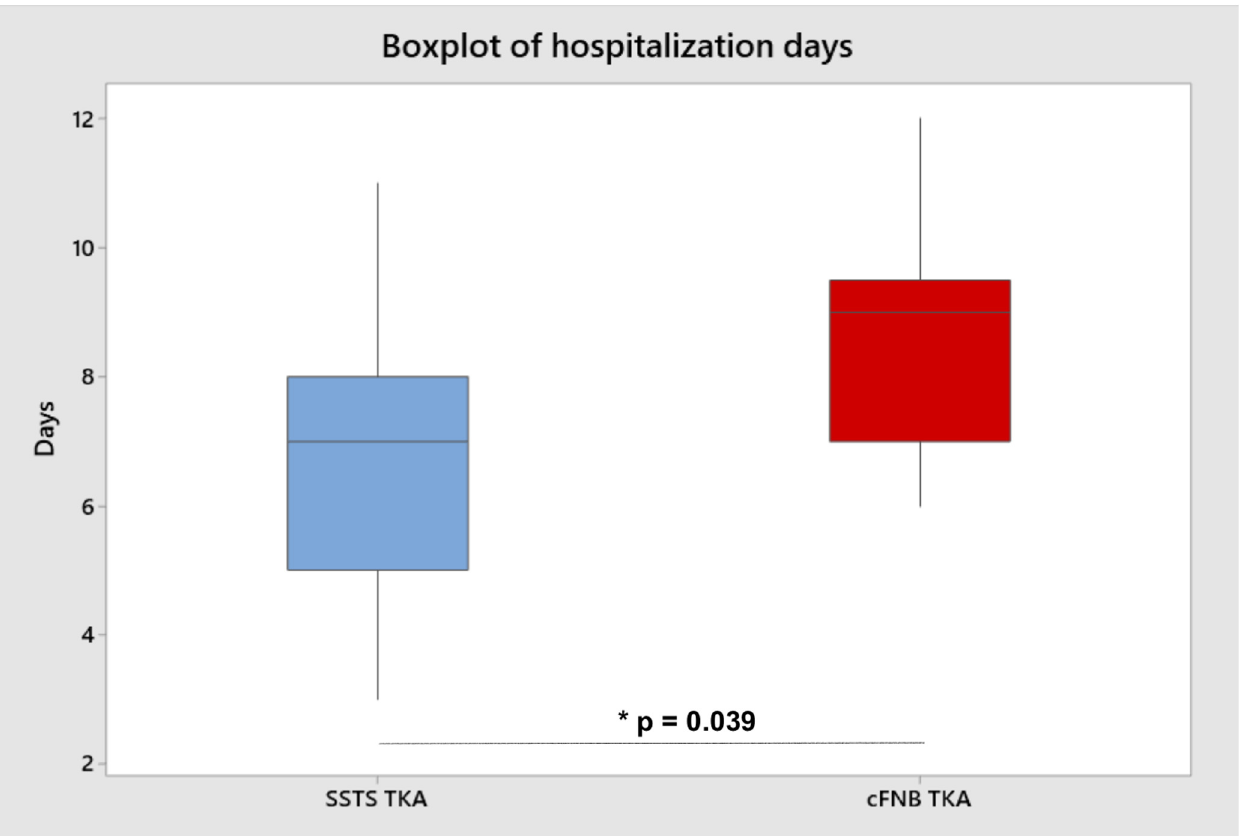
Figure 5. Boxplot analysis hospitalization between the two groups. Horizontal line represents mean value, and the square box represents interquartile range. ( p = 0.039) *.